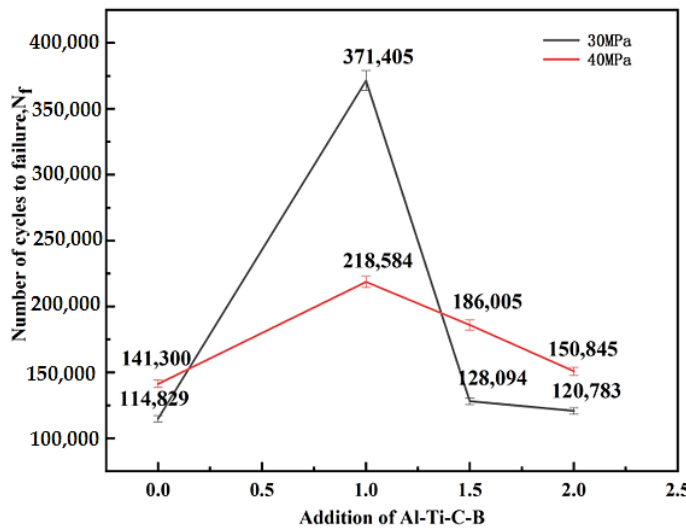
Figure 13. Fatigue properties of Al-12Si-4Cu-2Ni-1Mg alloy with different amounts of Al-2Ti-0.5B- 0.5C master alloy.